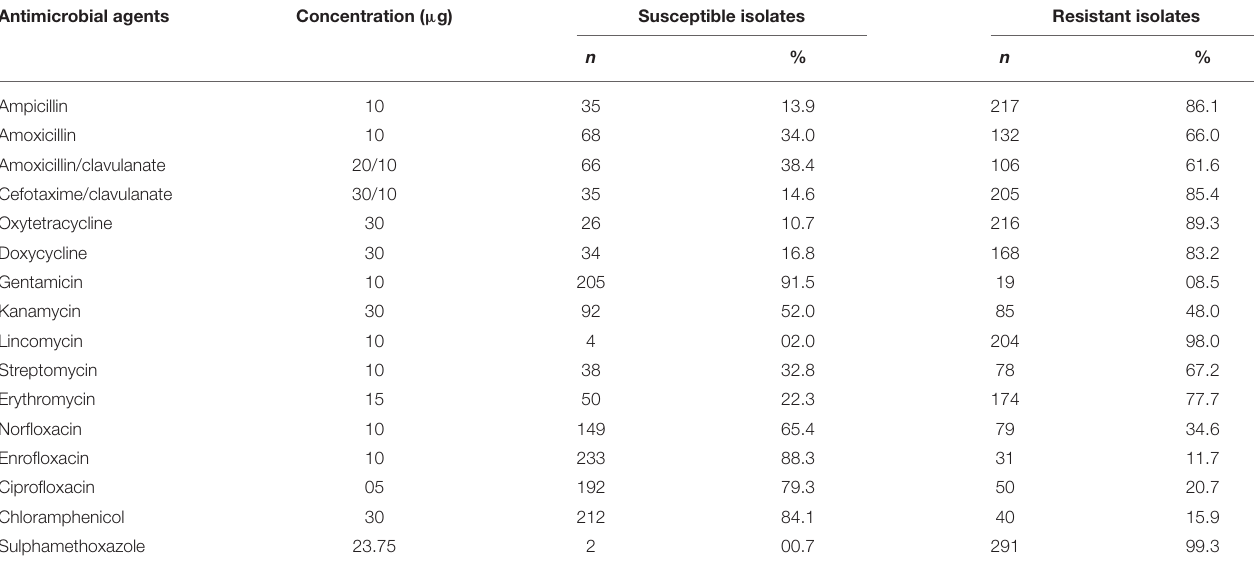
TABLE 6 | Antimicrobial susceptibility of bacterial isolates from mastitic cattle and buffaloes. Antimicrobial agents Concentration ( µ g) Susceptible